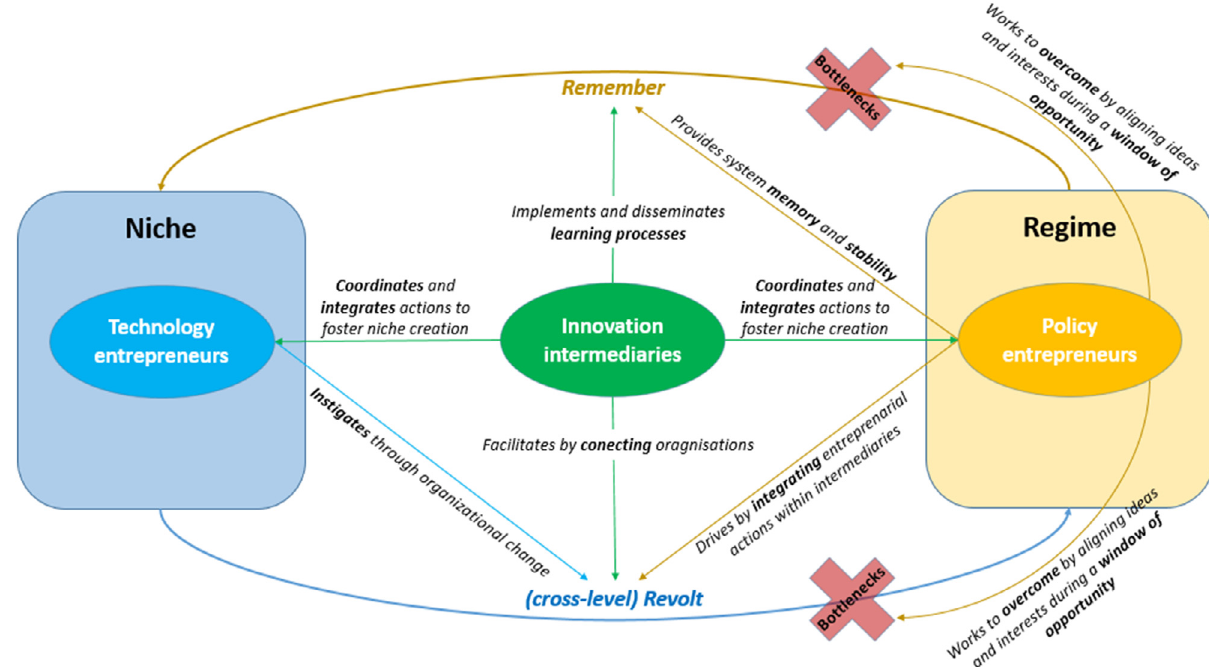
Figure 1. MLP framework for the development of innovative systems: Intermediaries as agents for stimulating transitions. Notes: the research question of this paper (shown in Sect. 2.3) focuses on the revolt process. Future research could further investigate the remember